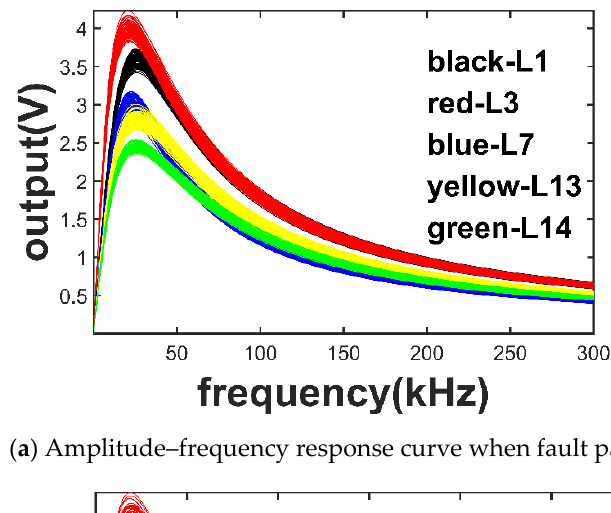
Figure 5. Amplitude–frequency response curves of several labels of faults in two cases. ( a ) Amplitude–frequency response curve when fault parameters are fixed.